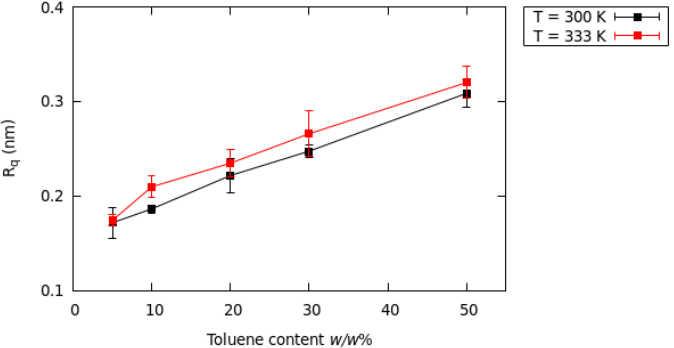
Figure 8. Surface roughness R q (nm) of the mixed film with standard error (sample size is 3) at different toluene contents.